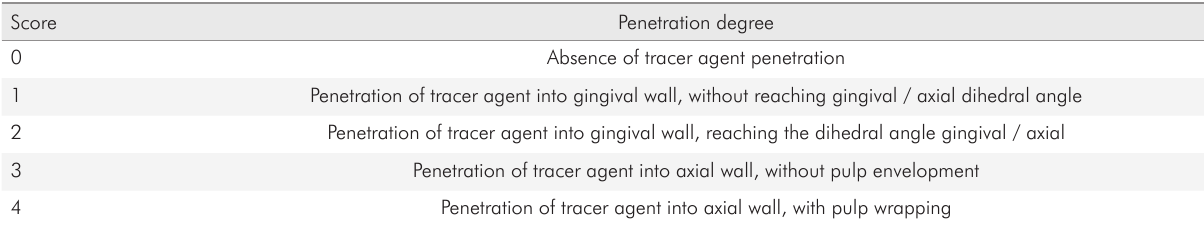
Table 2. Score for penetration degree of tracer agent at composite/tooth interface